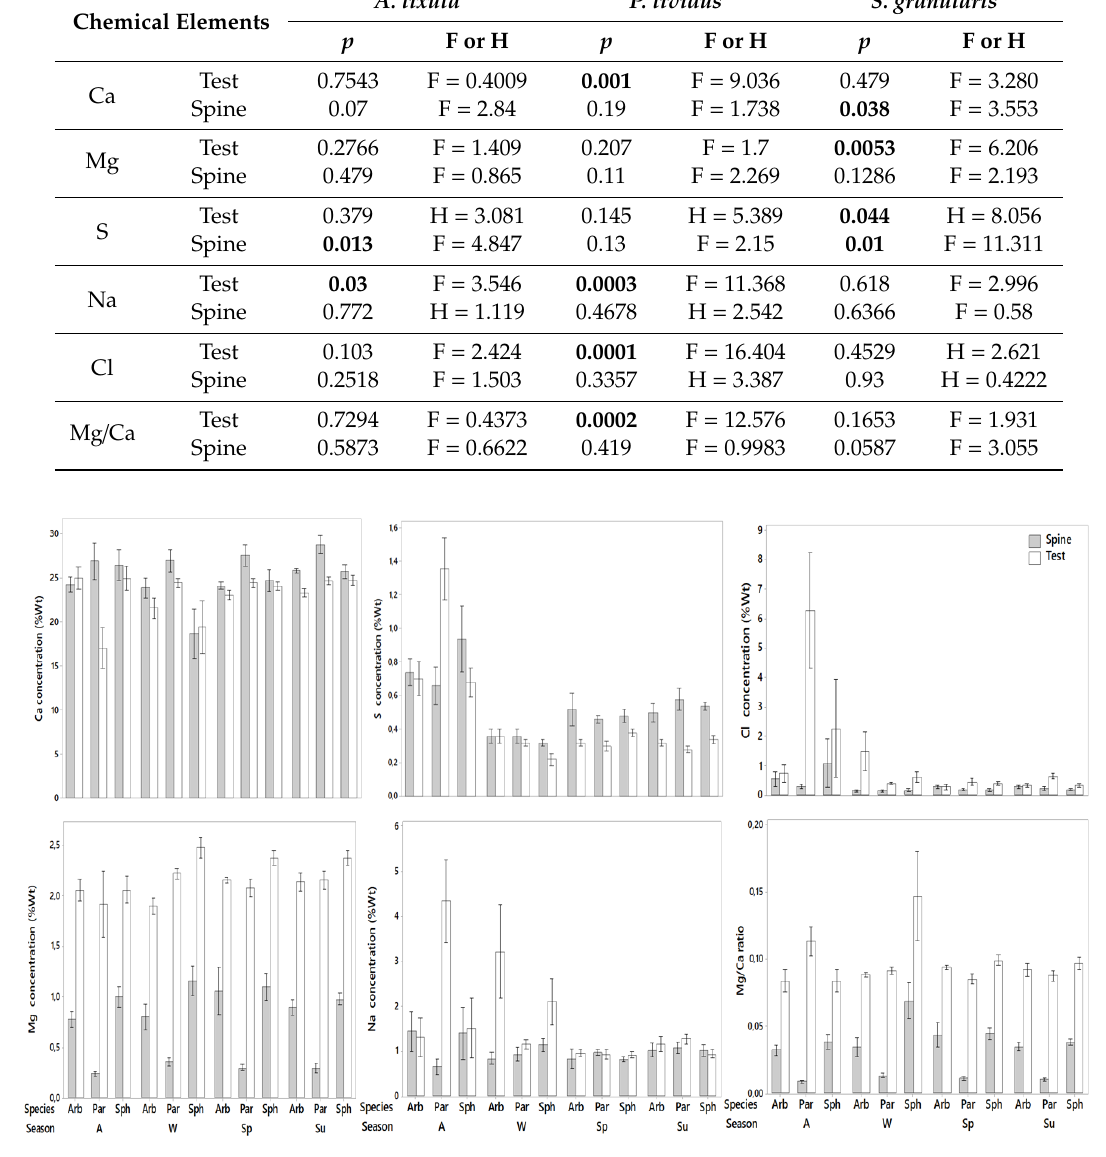
Figure 6. Temporal wt% concentrations of Ca, Mg, S, Na, Cl and Mg/Ca ratio in the spines and tests of the three species.